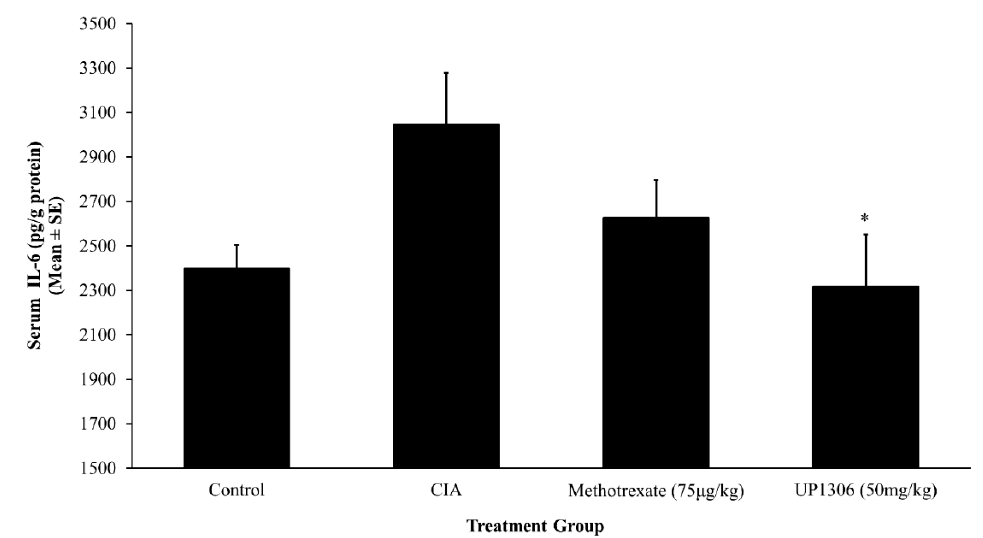
Figure 7. Effect of UP1306 on rat serum IL-6 level normalized with protein in CIA model treated for three weeks post immunization. Data are Mean ± SE. * p ≤ 0.05 vs. vehicle treated CIA.